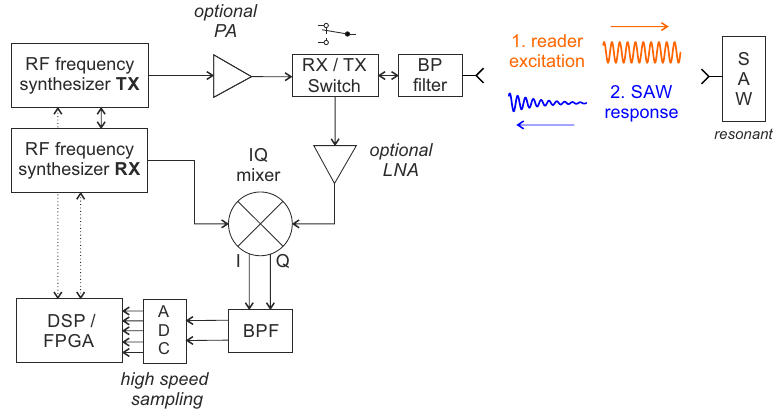
Figure 9. Block diagram of the reader concept for time domain sampling with digital frequency